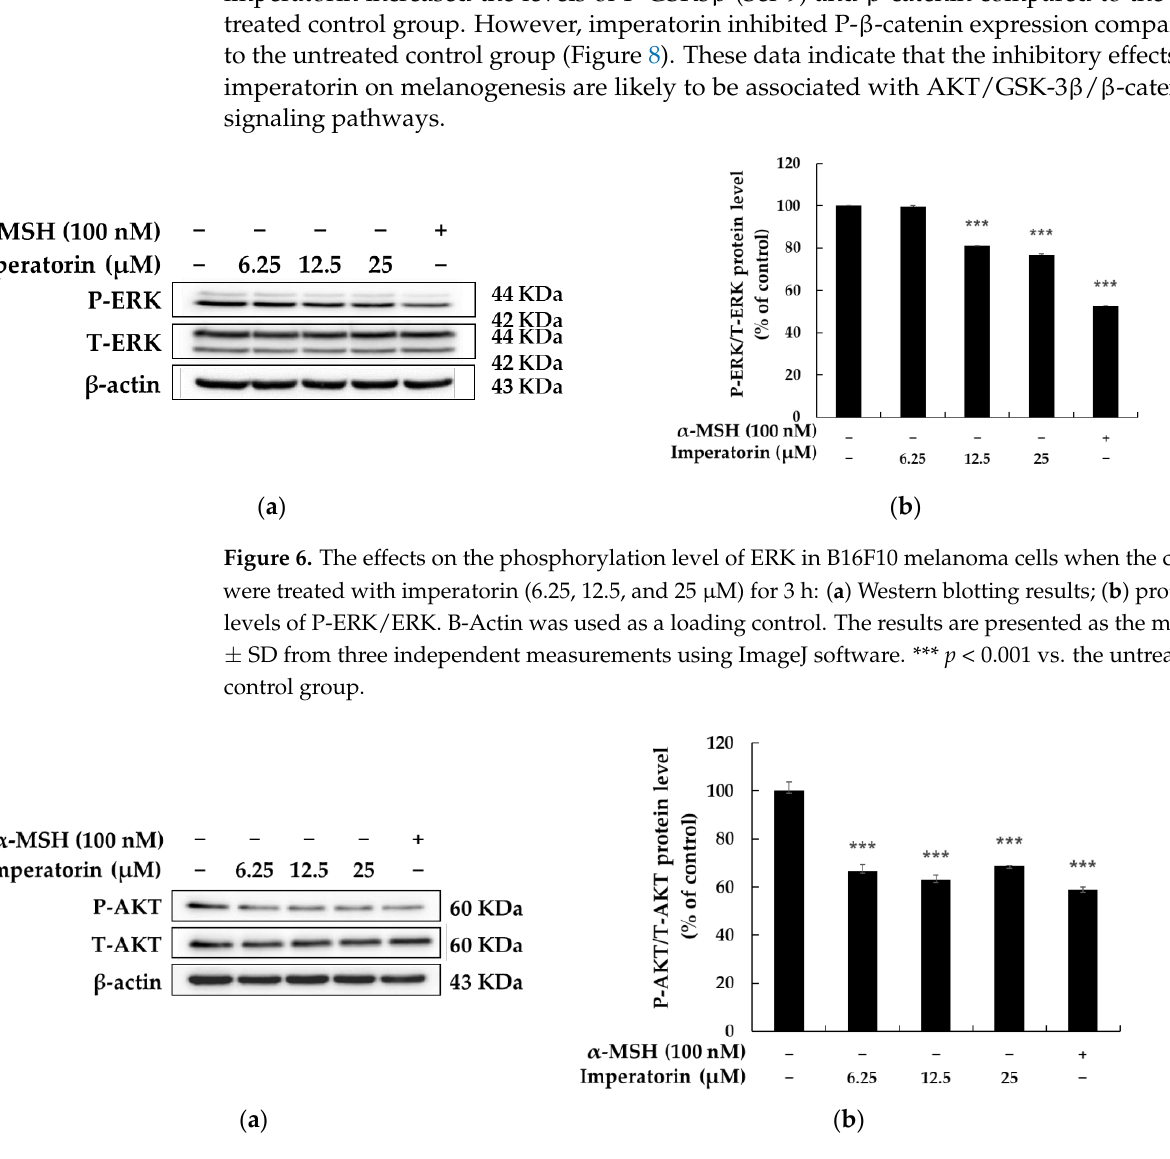
Figure 6. The effects on the phosphorylation level of ERK in B16F10 melanoma cells